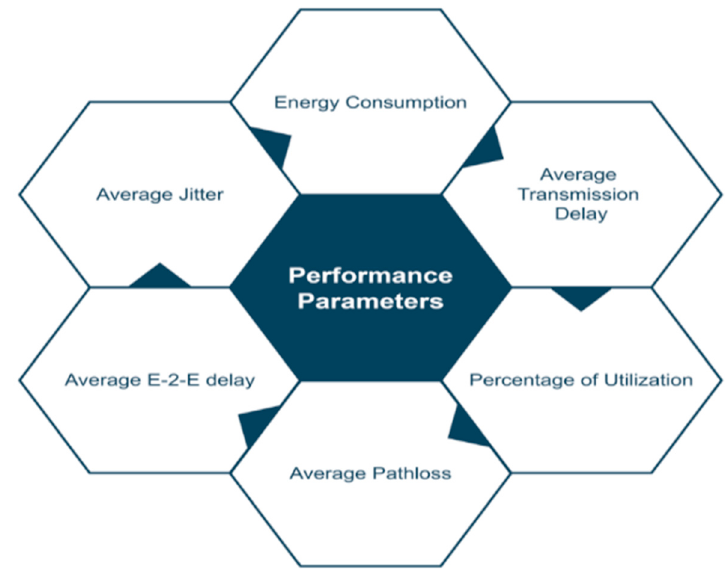
Figure 8. Performance parameters of UWSN.